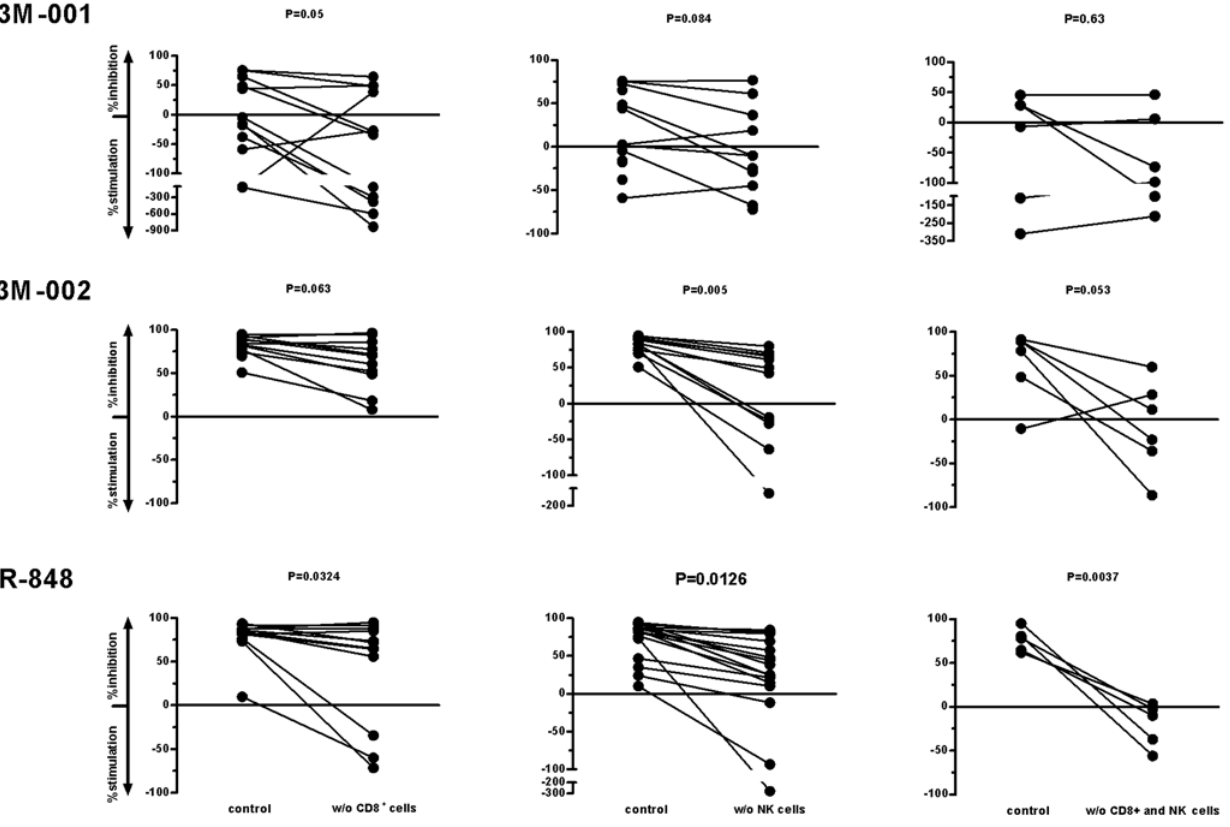
Figure 3. NK cells and CD8 + T-cells are the effector cells responsible for the anti-HIV effects in PBMC after triggering TLR8 or TLR7/ 8. PBMC from different donors were either depleted of CD8 + T-cells or NK or both, treated with the various TLR7 and/or 8 agonists and infected with the X4-tropic strain NL4-3 two days later. HIV infection was monitored by measuring p24 antigen in the supernatant over time. Statistical analysis was done by paired